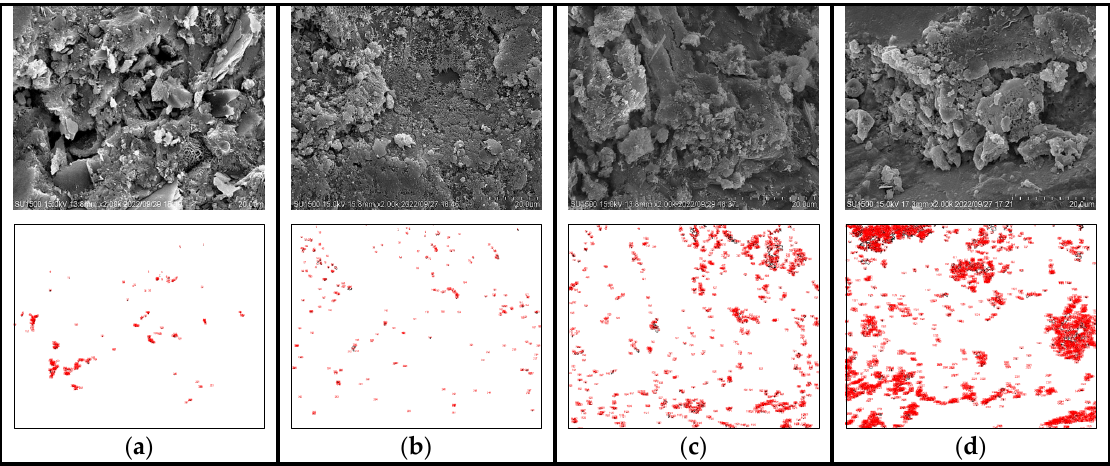
Figure 14. Micromorphology and the correlating pore outline drawing of the control group with different cycles times: ( a ) 0, ( b ) 25, ( c ) 50, ( d ) 75.